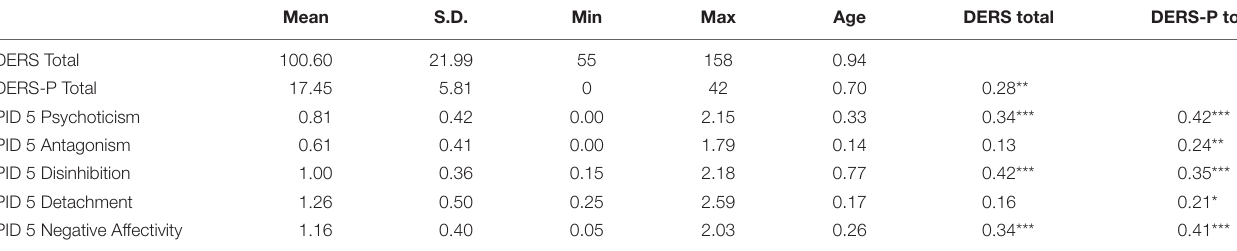
TABLE 2 | ERA: Descriptive statistics ( N = 128) and zero-order correlation (Pearson).